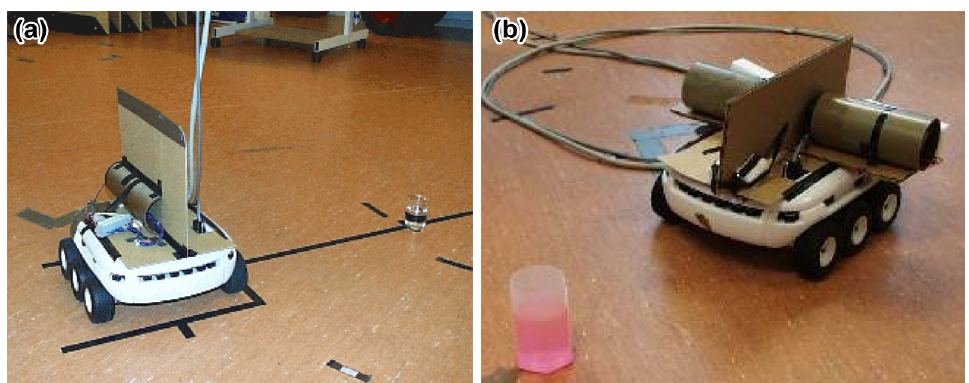
Figure 21 . The ¨Orebro Mark I (a), and the ¨Orebro Mark II mobile nose (b).